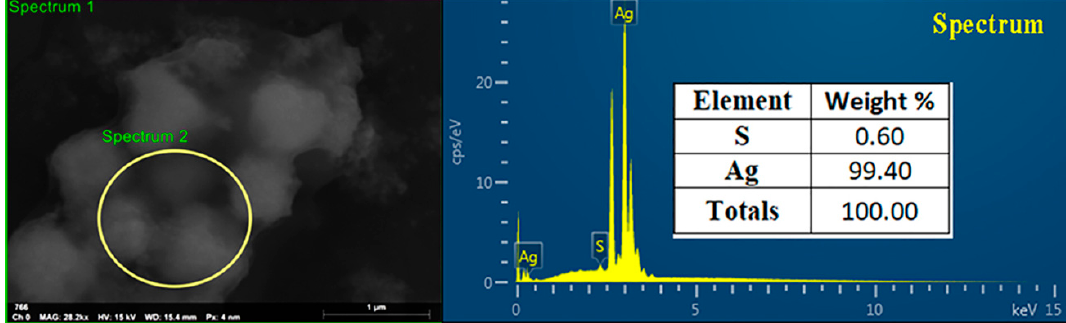
Figure 10. Energy dispersive spectrum showing the predominance of Ag and S elements in the AgNPs.